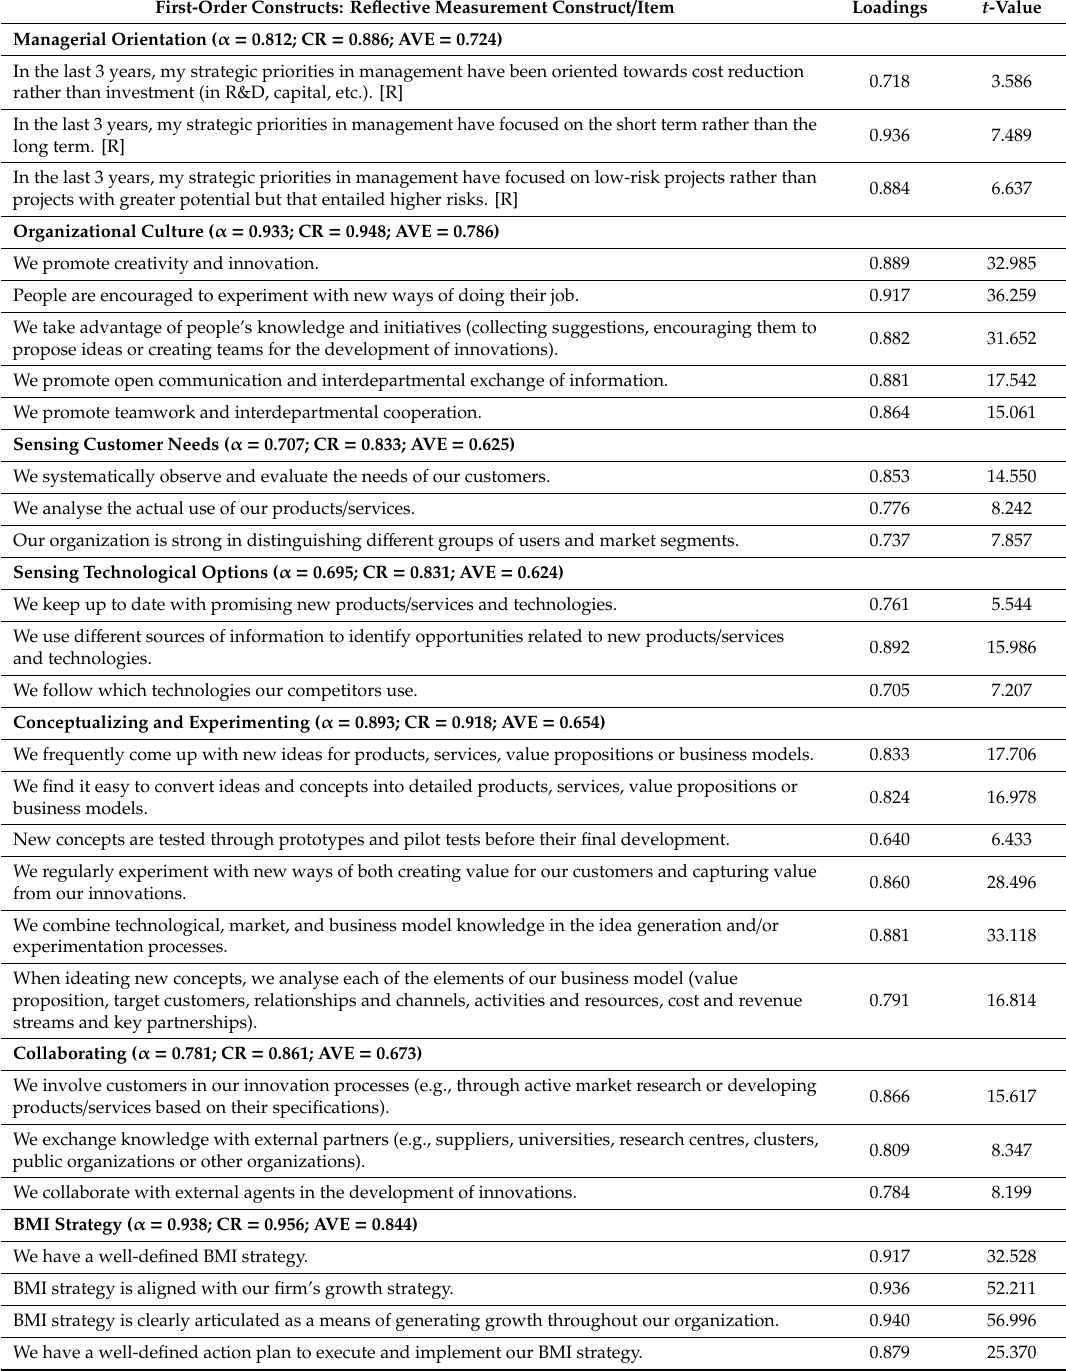
Table A1. Questionnaire: